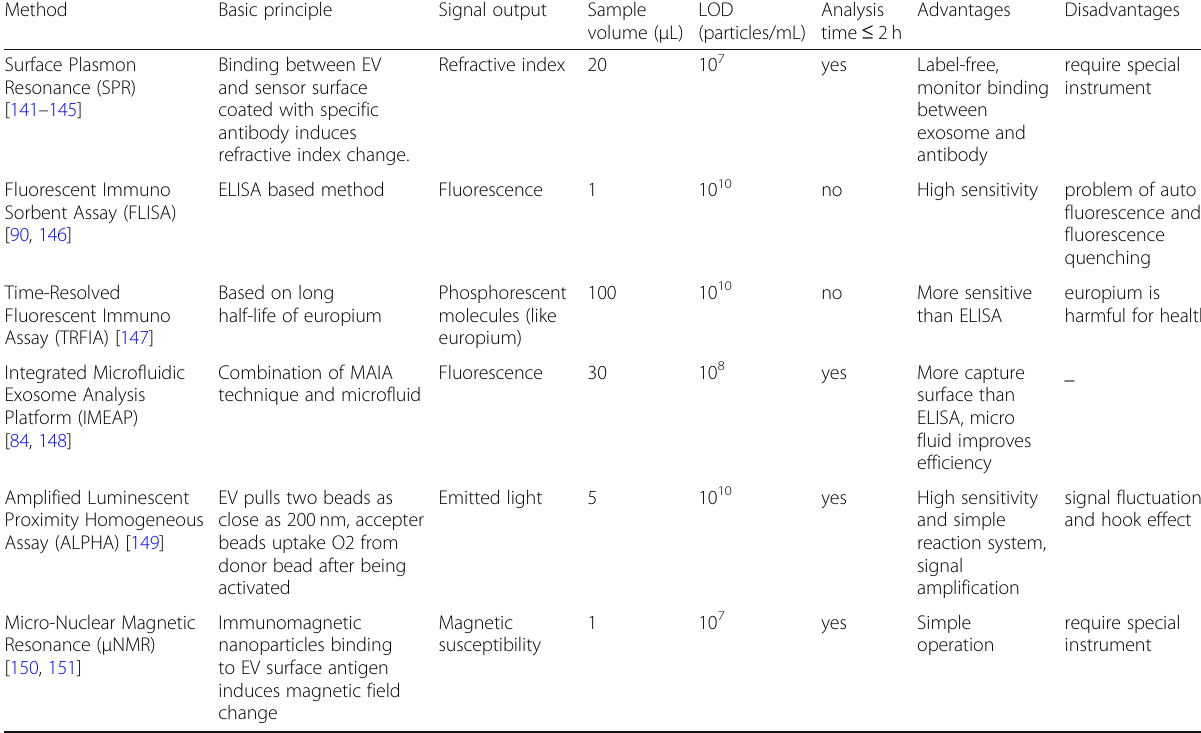
Table 4 Classic immune analysis techniques for exosome proteins